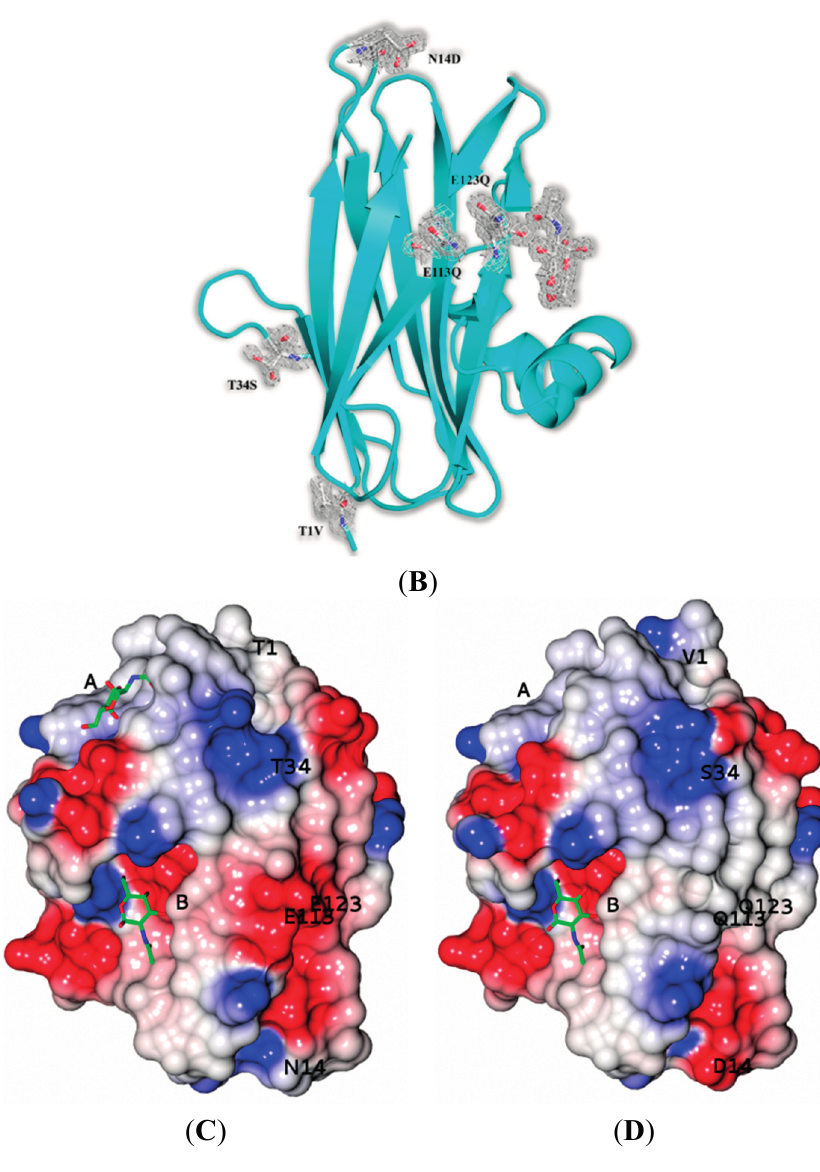
Figure 2. ( A ) Comparison of amino acid sequences of SSR1 and SSR2 with SRL. Mutated residues are in bold and shaded. Every 10th residue in the SRL sequence is